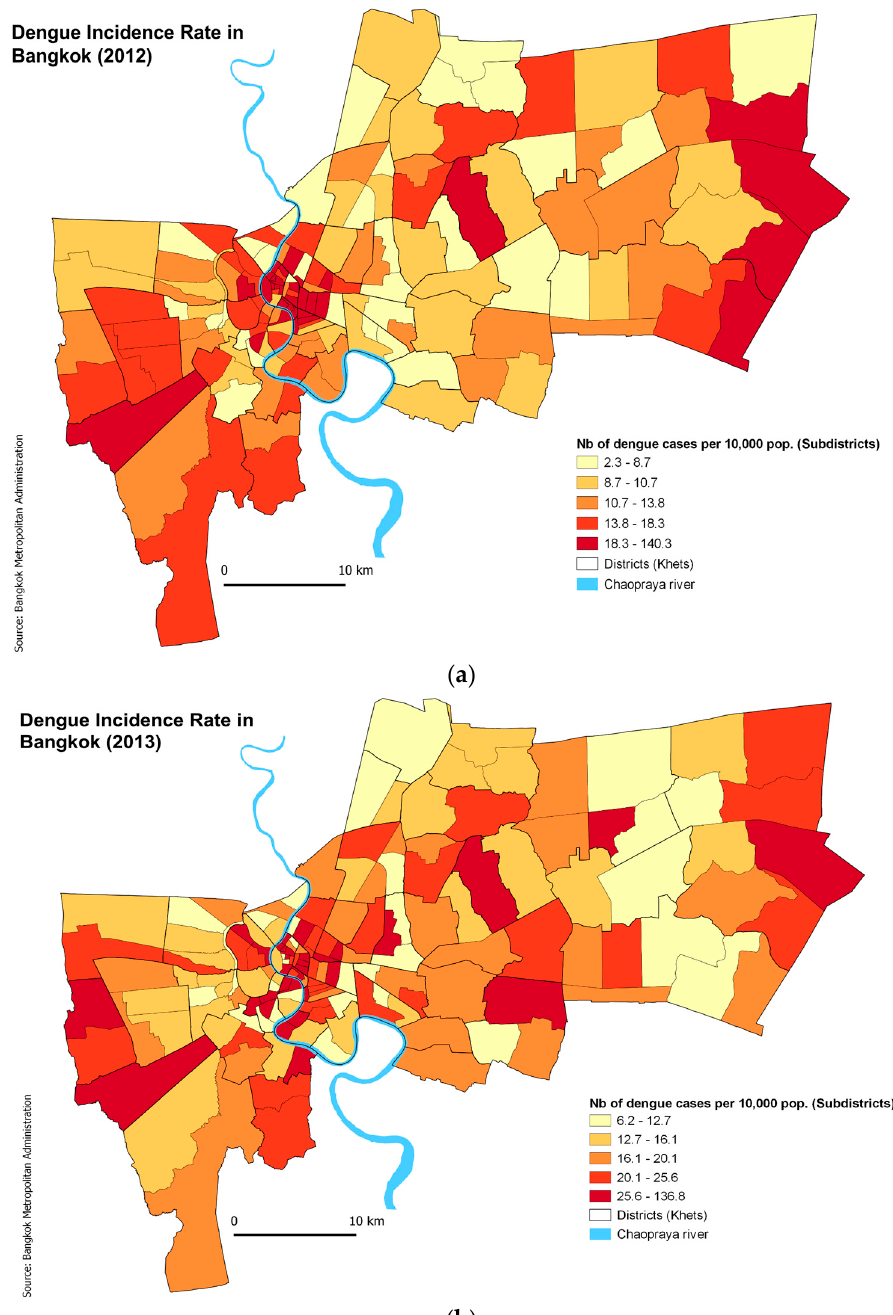
Figure 1. Incidence rate of dengue cases across the subdistricts of Bangkok in ( a ) 2012 and ( b ) 2013. Over the two years, 51 out of a total of 160 subdistricts were classified into a cluster type. Nineteen subdistricts were identified as clusters/outliers in both years, 14 of which had the same category (4 High–High, 7 Low–Low and 3 Low–High), two changed from High–High to Low–High, two from Low–Low to High–Low and one from Low–High to